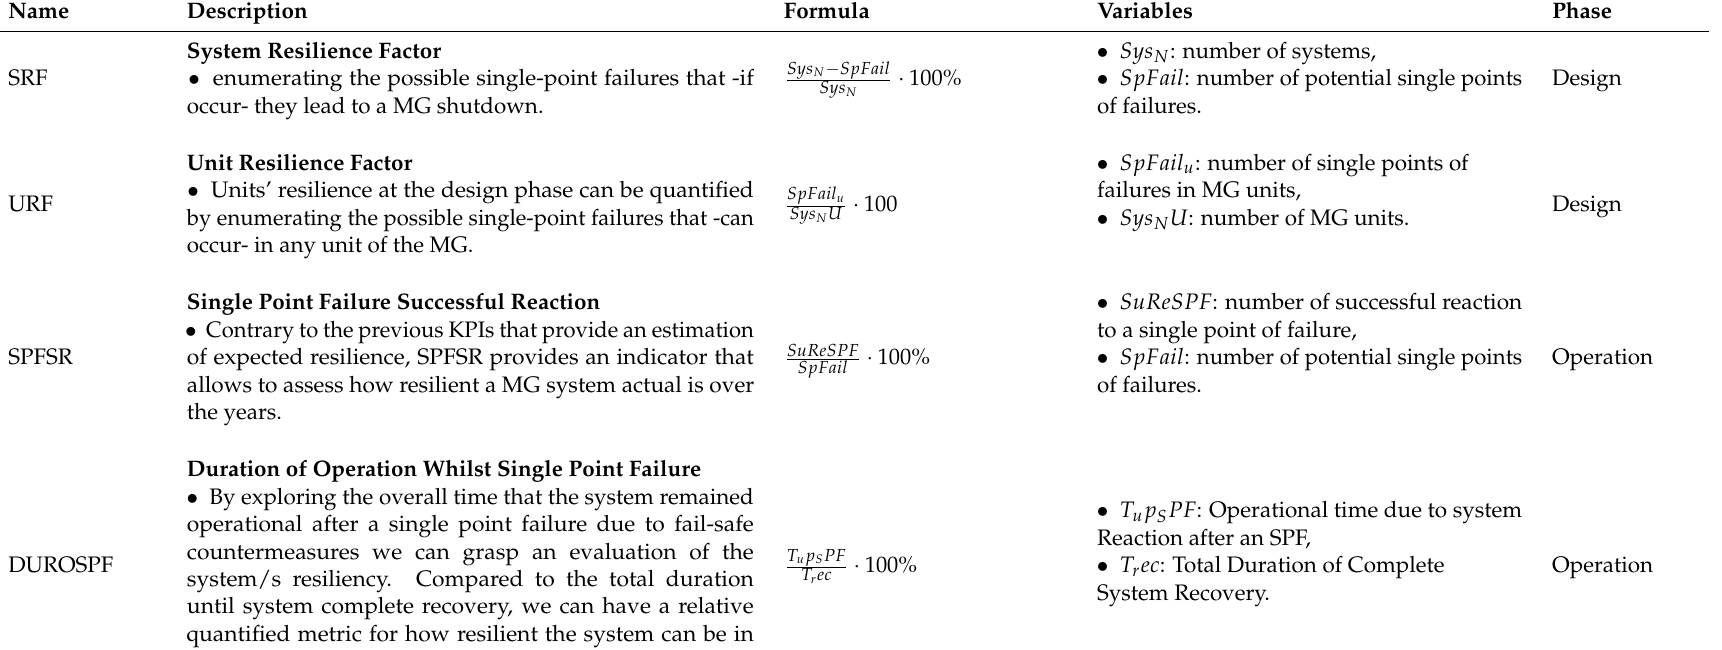
Table A4. Detailed Representation of MG Resiliency